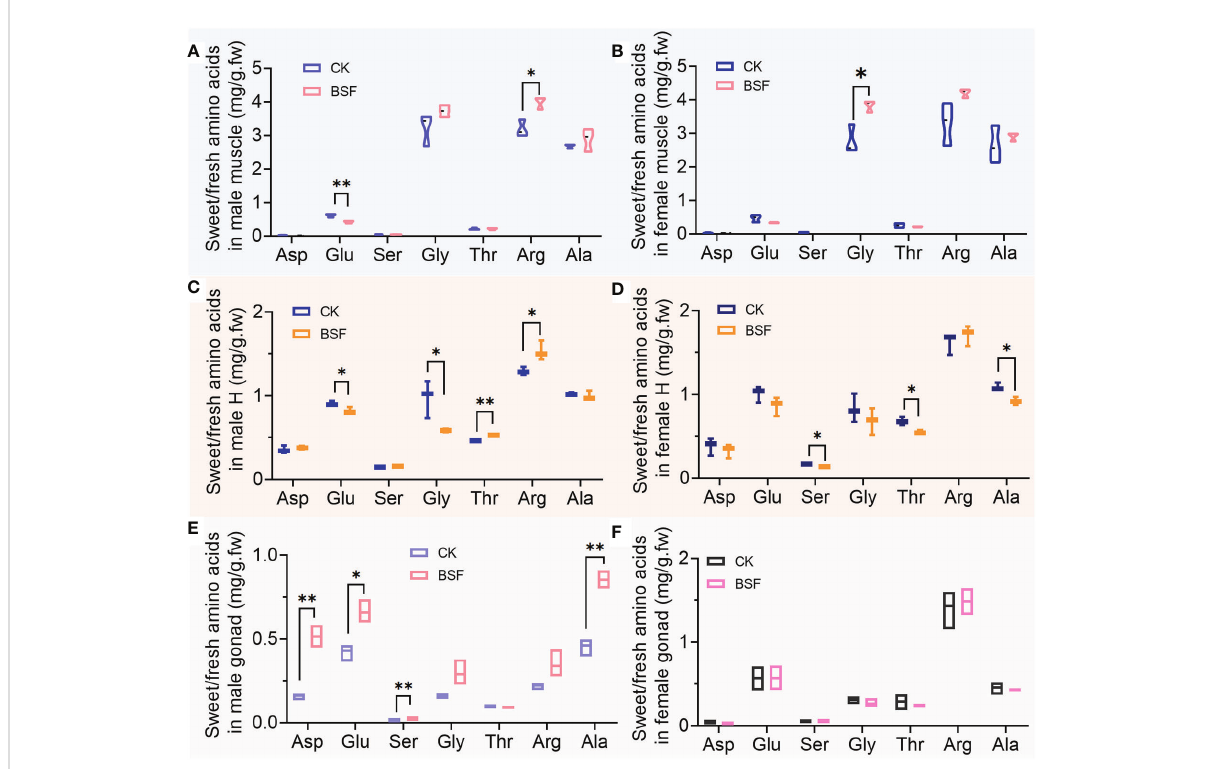
FIGURE 2 Effects of BSFL feeding on delicious amino acid levels in edible tissues of mitten crabs. Levels of amino acid with a sweet/umami taste in male and female muscles (A, B) , hepatopancreas (C, D) , and gonads (E, F) . CK, control group; BSF, experimental group. H, hepatopancreas; Asp, aspartic acid; Glu, glutamic acid; Ser, serine; Gly, glycine; Thr, threonine; Arg, arginine; Ala, alanine. * P ≤ 0.05; ** P ≤ 0.01. n =